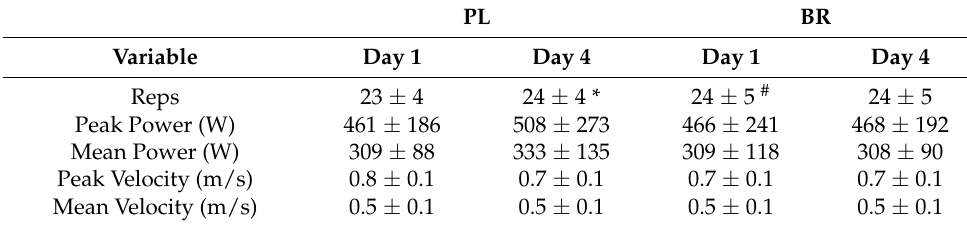
Table 10. Performance outcomes during a bench press exercise protocol for determination of muscular endurance following acute and multiday nitrate supplementation. PL